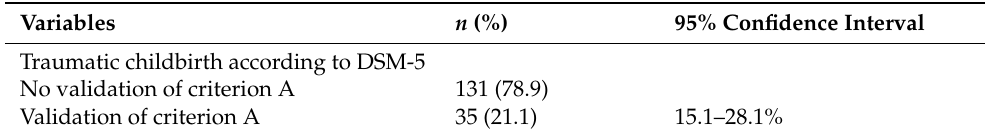
Table 5. Prevalence of traumatic childbirth defined by criterion A for traumatic events according to